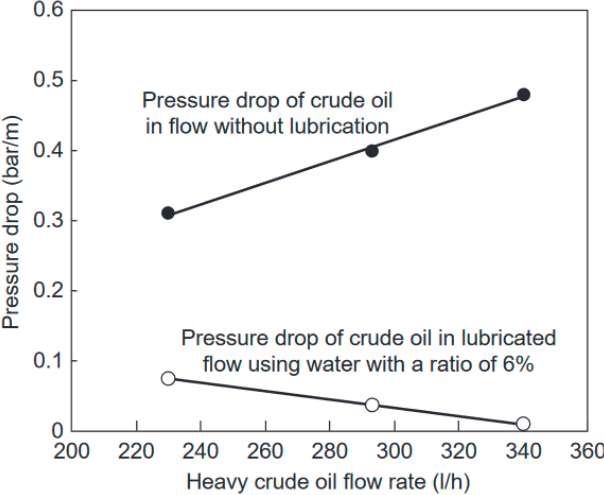
Figure 2. Comparison of pressure drop with and without lubrication [17].